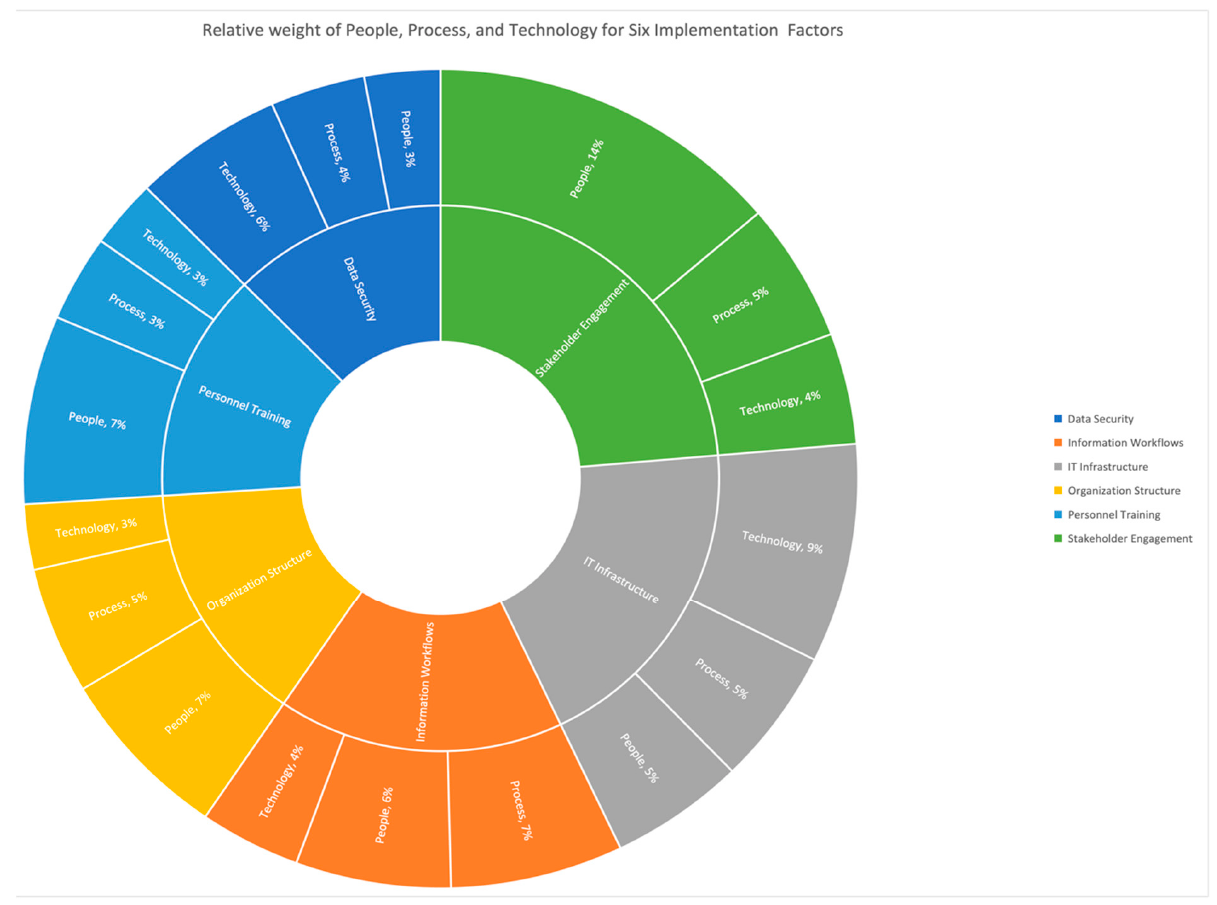
Figure 3. Relative weights of People, Process, and Technology for six factors of technology imple- mentations.